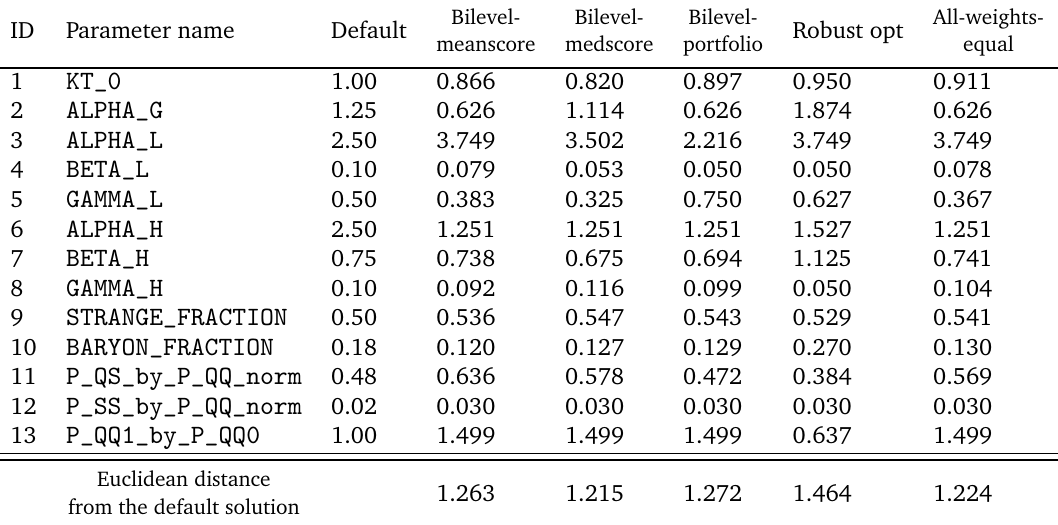
Table 29: Optimal parameter values for the S HERPA dataset obtained with all methods using the cubic polynomial approximation after using the bin-filtering approach that excludes individual bins from the optimization (204 bins out of 5246 total bins were removed).